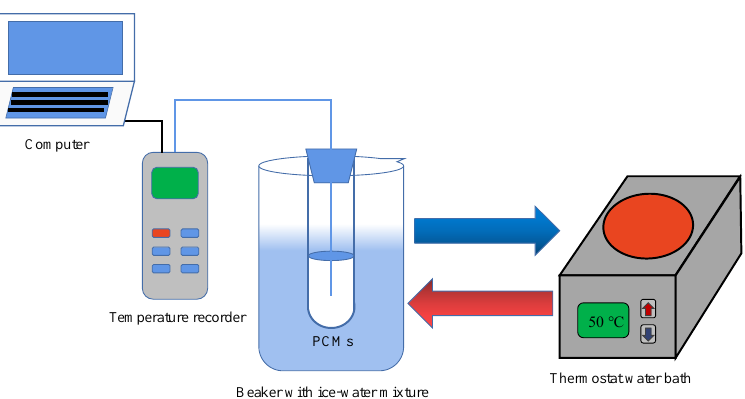
Figure 1. Schematic of the thermal performance evaluation system of paraffin and SS-PCMs.